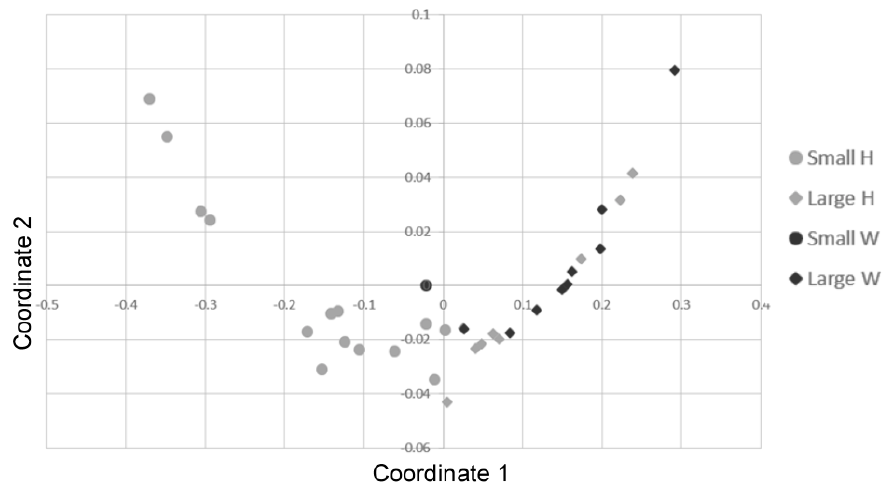
Figure 2. Non-Metric Multidimensional Scaling of body size distribution in the loggerhead turtles (parameters: CCL, curved carapace length and CCW, Curved Carapace Width) using the Bray-Curtis coefficient. Different size classes and health status are reported: small size = circle; large size = rhombus; heathy (H) = grey; weak (W) = black. Stress = 0.009511.